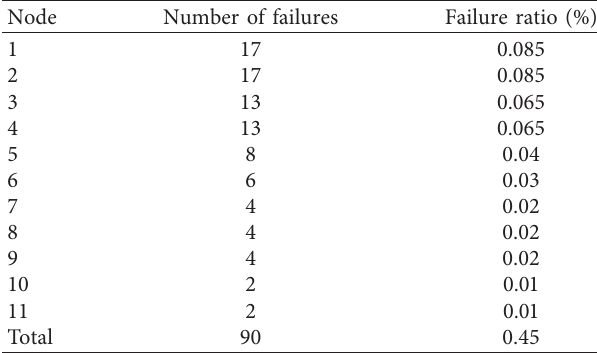
Table 2: Total number of